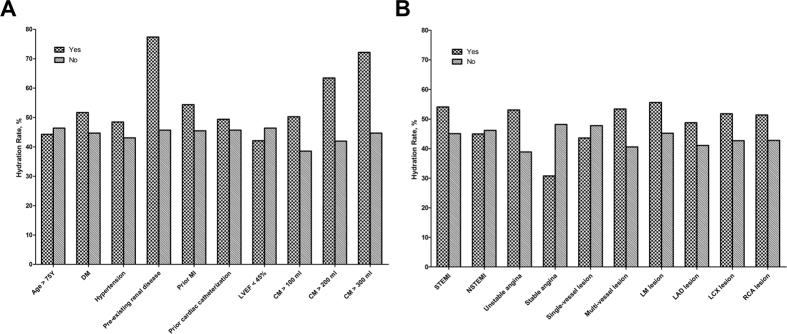
Hydration rate status of patients.(A) Hydration rate of patients with or without risk factors; (B) Hydration rate of patients with different coronary diseases. Abbreviations: DM, diabetes mellitus; MI, myocardial infarction; LVEF, left ventricular ejection fraction; CM, contrast medium; STEMI, ST segment elevation myocardial infarction; NSTEMI, non-ST segment elevation acute myocardial infarction; LM lesion, left main lesion; LAD lesion, left anterior descending branch lesion; LCX lesion, left circumflex branch lesion; RCA lesion, right coronary lesion.